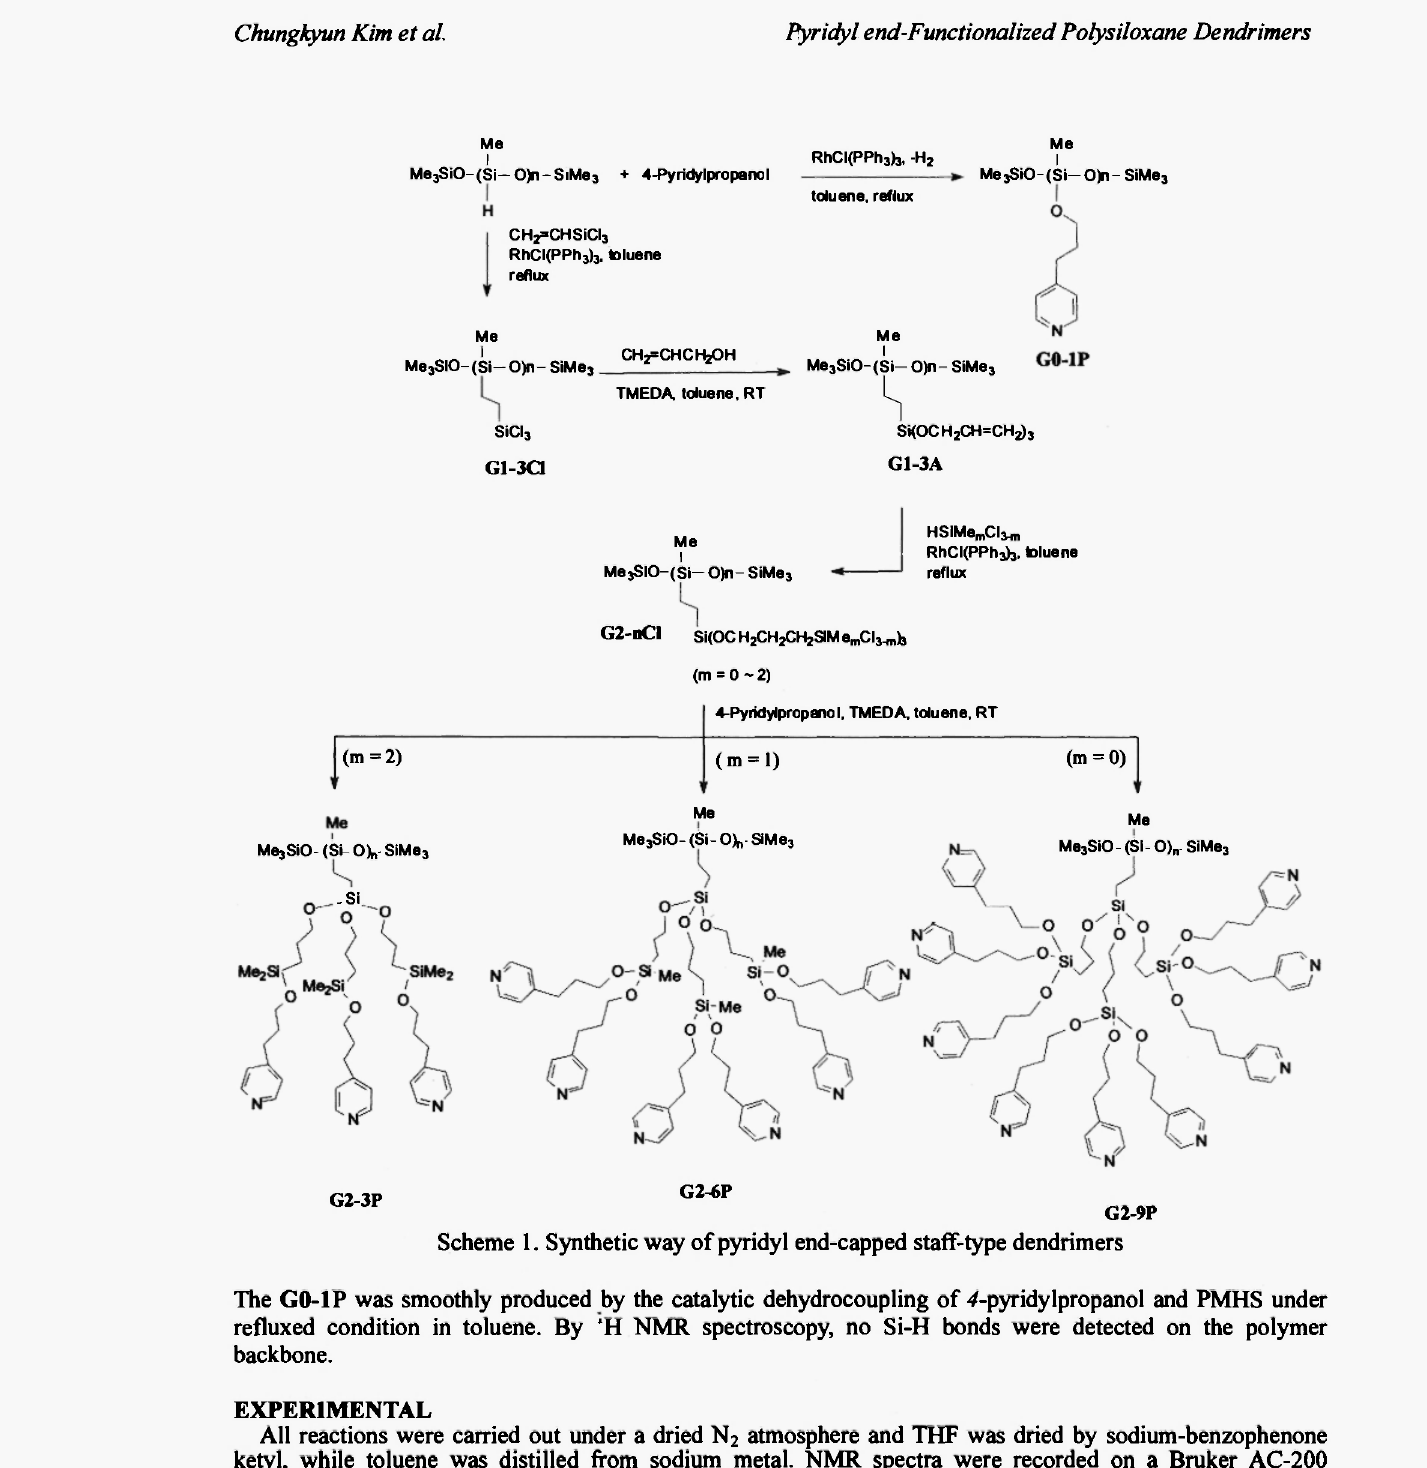
Scheme 1. Synthetic way of pyridyl end-capped staff-type